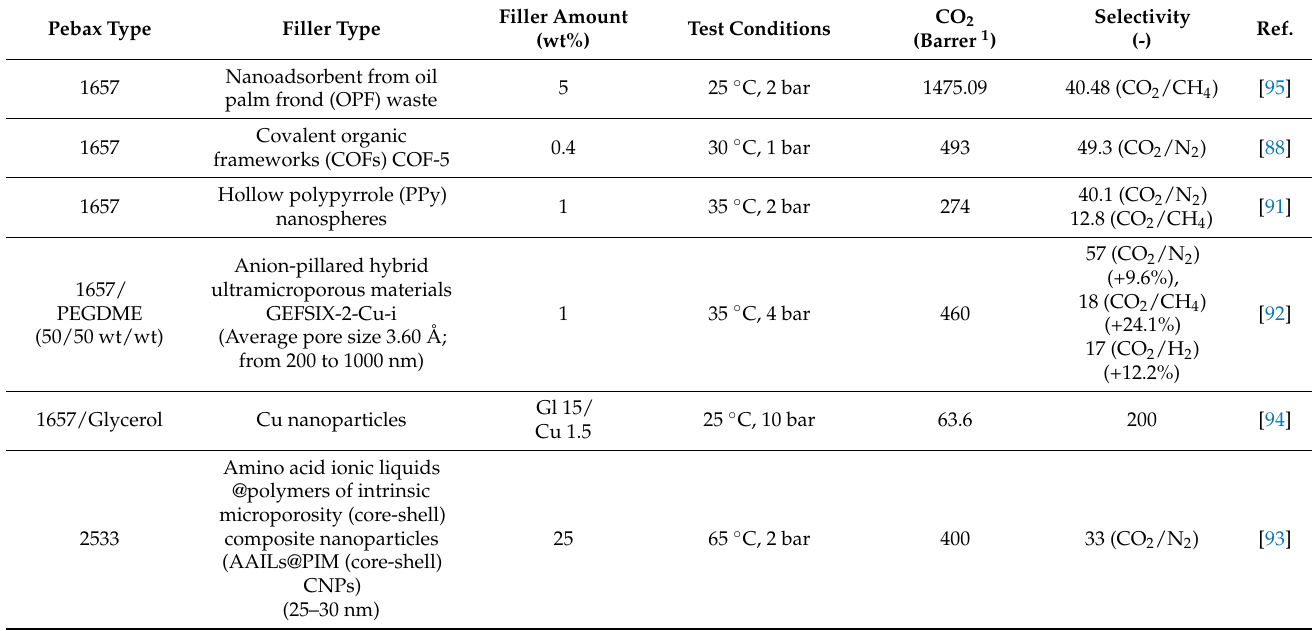
Table 9. Permeation properties of selected Pebax-based MMMs filled with other solid